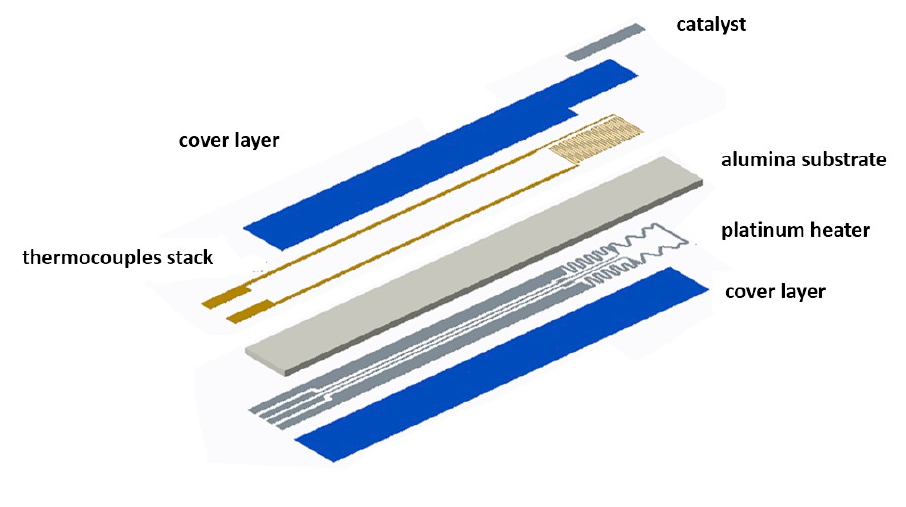
Figure 1. Scheme of the thermoelectric hydrocarbon